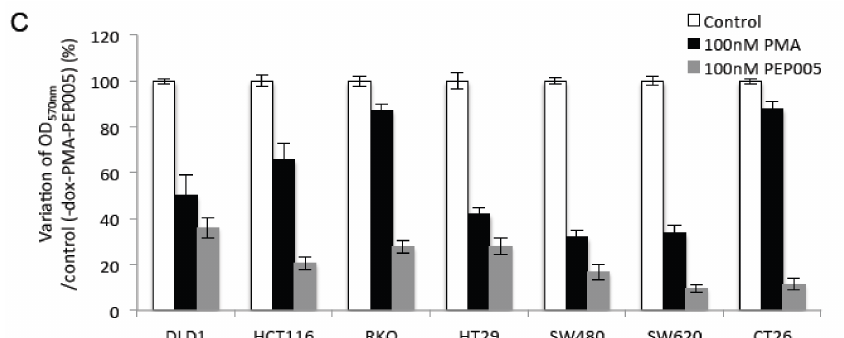
Figure 7. PMA and PEP005 di-terpene esters inhibit CRC cell growth in a concentration-dependent manner with distinct potentials. ( A ) Quantification of crystal violet assays in DLD-1-PKC α cells exposed or not to 1 µ M doxycycline and increasing concentrations of PMA or PEP005, as indicated, for 10 days. OD 570 nm values (compared with the control condition in the absence of doxycycline and PMA or PEP005) show that increasing PKC α expression and activity by doxycycline and PMA or PEP005 strongly promotes growth arrest. Note that the required concentrations are 10 times higher for PEP005 than for PMA to reach similar e ff ects. Crystal violet assay performed in a panel of CRC cell lines incubated or not for 10 days with ( B ) 1 nM PMA or PEP005 and ( C ) 100 nM PMA or PEP005. OD 570nm values (compared with the control condition without PMA or PEP005) show the strong e ff ect of PMA at low concentration (1 nM) in a limited number of CRC cell lines. PEP005 did not have any e ff ect at low concentration (1 nM), but showed strong growth inhibition at high concentration (100 nM) in all tested CRC cell